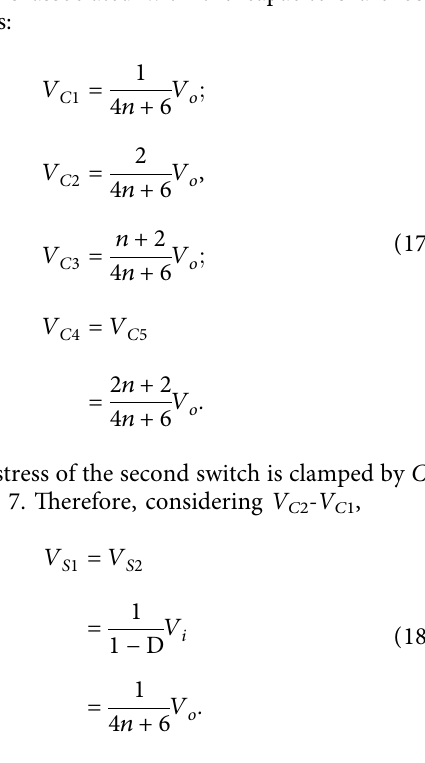
Figure 4: Circuits corresponding to the operation modes: (a) mode 1 [t (e) mode 5 [t 4 -t 5 ]; (f) mode 6 [t 5 -t 6 ]; (g) mode 7 [t 6 -t 7 ]; (h) mode 8 [t 7 -t 0